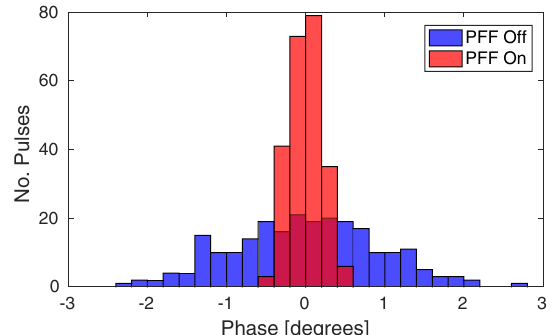
FIG. 7. Distribution of the mean downstream phase with the PFF system off (blue) and on